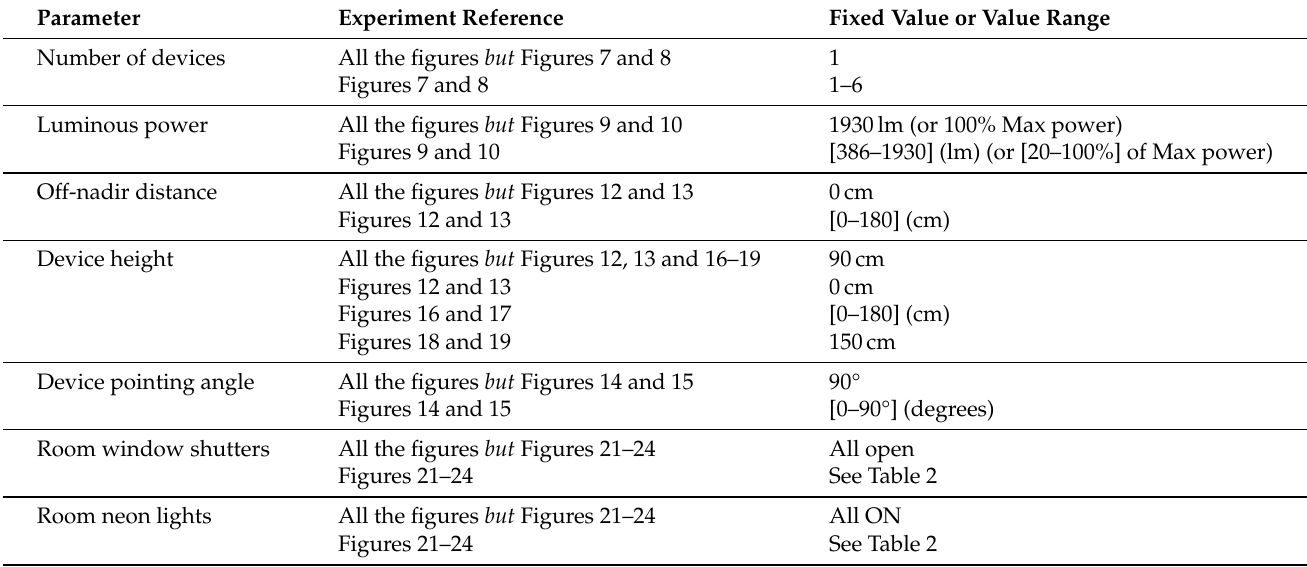
Table 1. Parameters